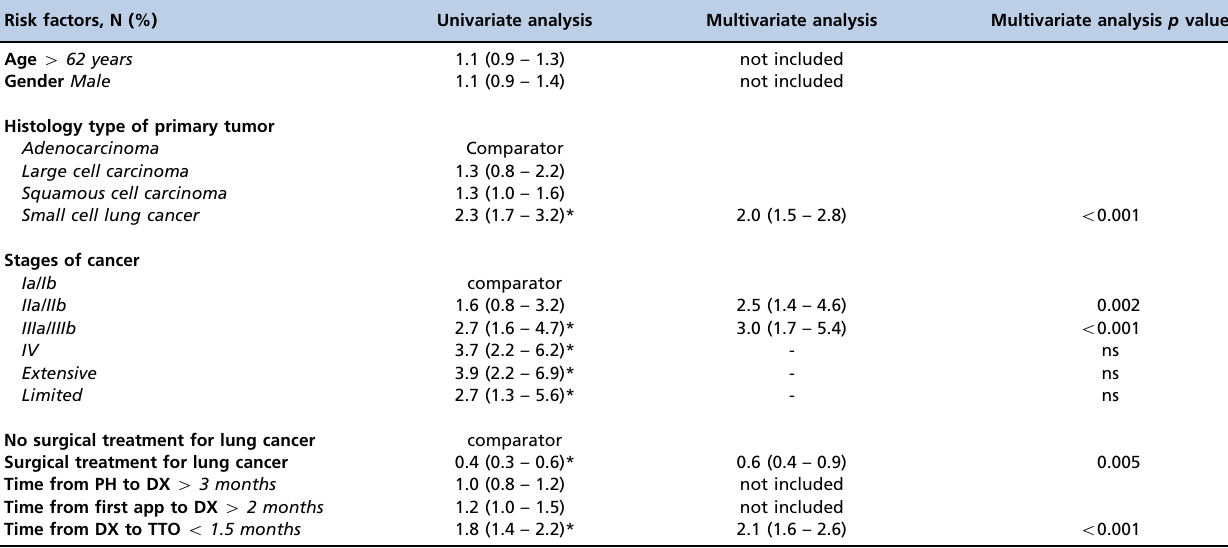
Table 3 - Risk factors (prevalence odds ratio, 95% CI) associated with patient death by univariate and multivariate analyses (Cox regression). Risk factors, N (%) Univariate analysis Multivariate analysis Multivariate analysis p value Age 4 62